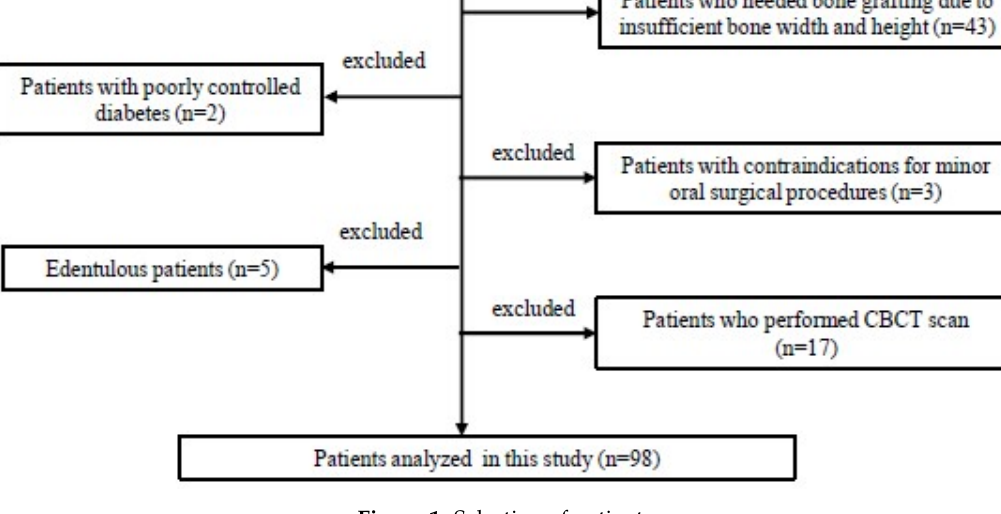
Figure 1. Selection of patients.